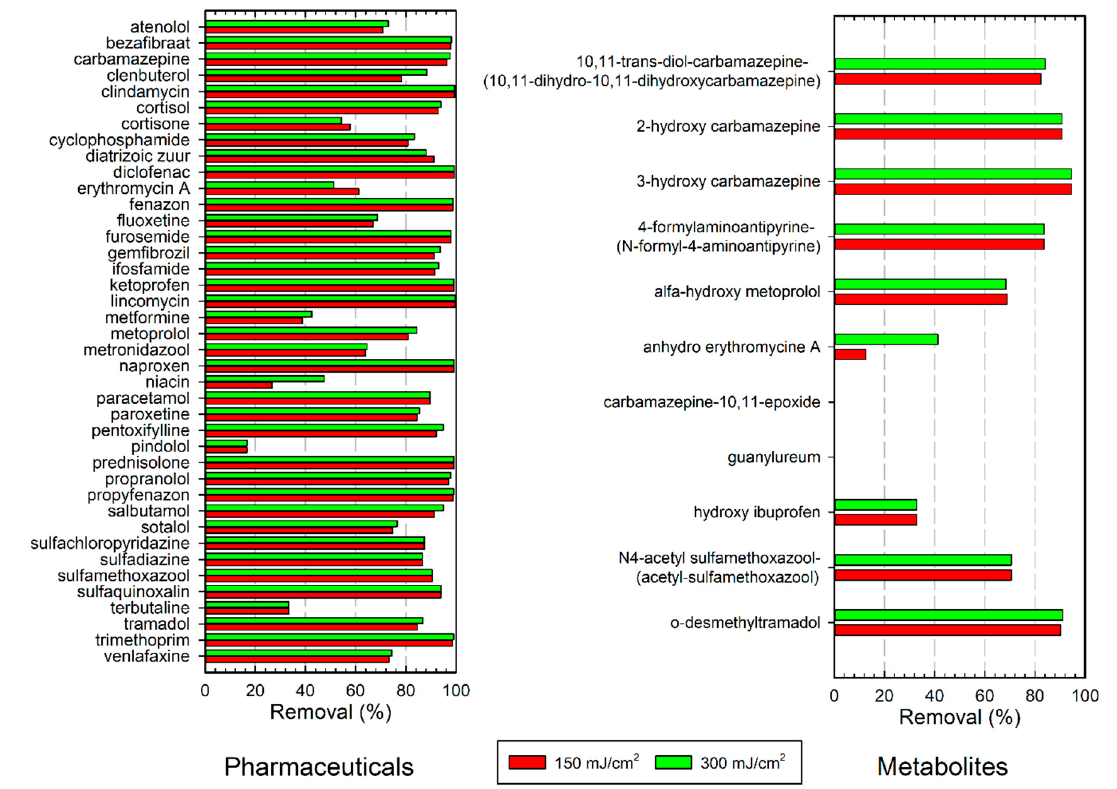
Figure 5. Removal of pharmaceuticals (left graph) and metabolites (right graph) in the effluent of WWTP Panheel, by applying ultraviolet (UV)/H 2 O 2 at a UV dose of 150 and 300 mJ/cm 2 .